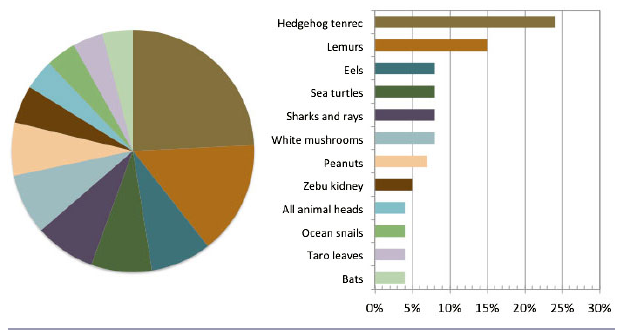
Fig. 1 . Species composition of all food taboos attributed to potential connections to zoonotic disease, allergies, and toxicity. Presented here is the species composition of illness-related food taboos as a proportion of all food taboos attributed to potential connections to zoonotic disease, allergies, and toxicity. Food items with fewer than three mentions in our research are not included in this